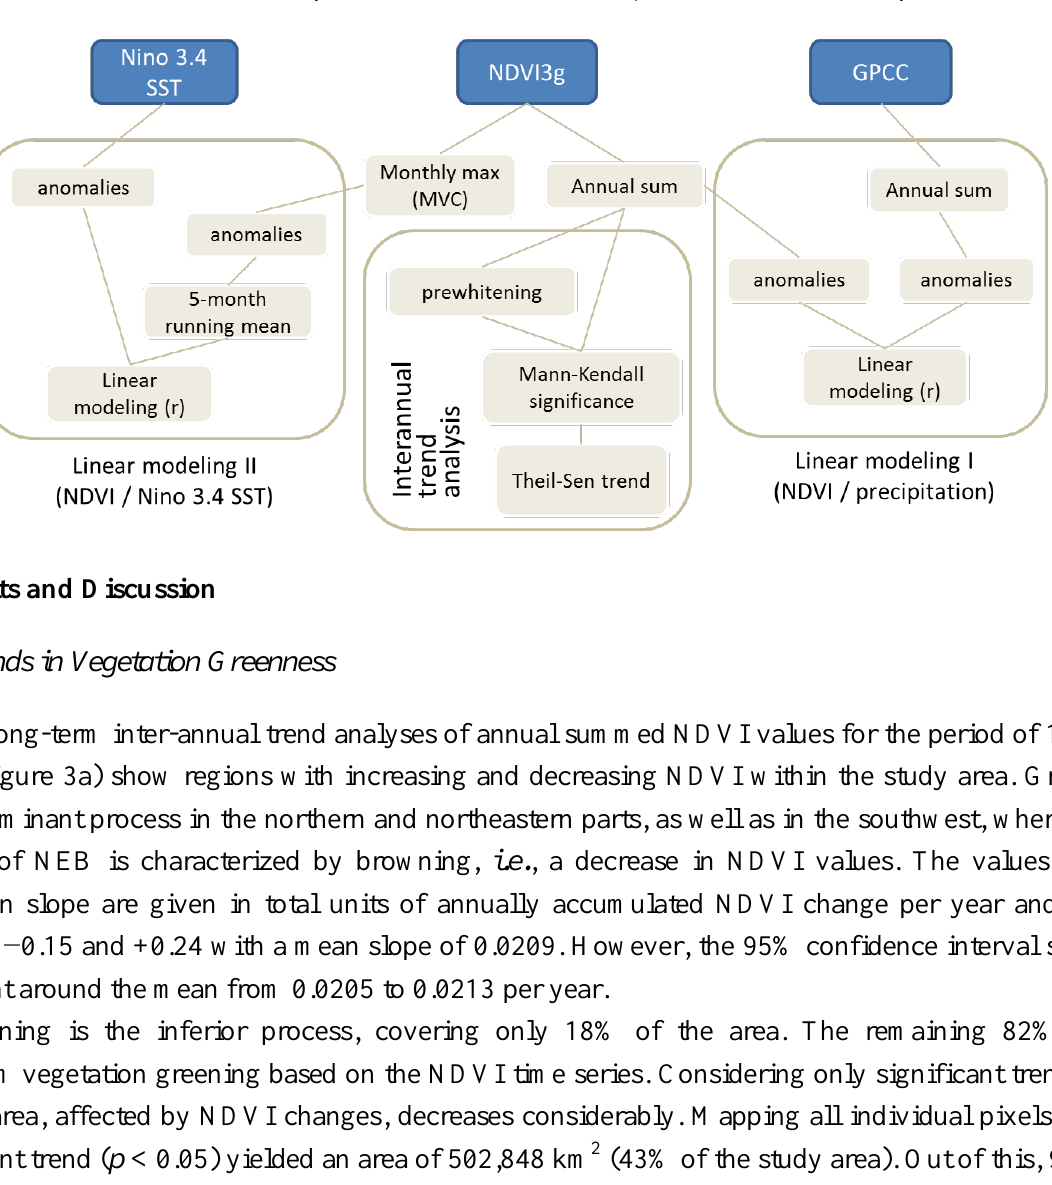
Figure 2. Workflow for the processing of time series from Normalized